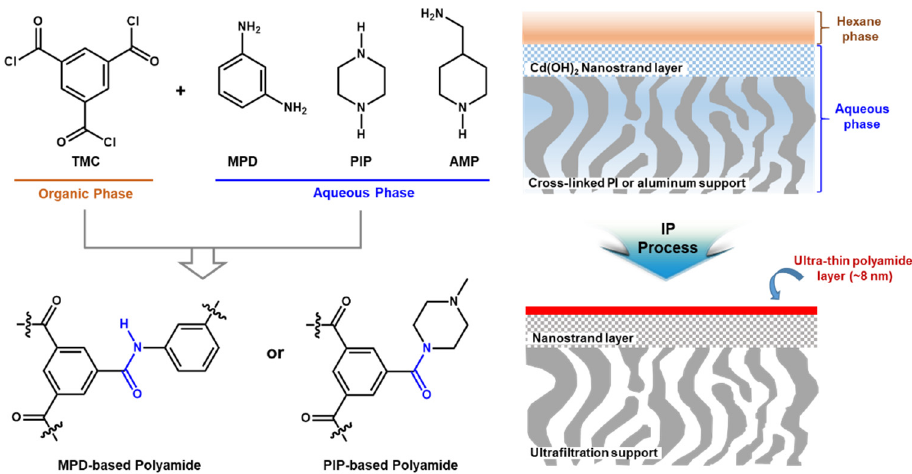
Figure 2. Ultra-thin m -phenylenediamine (MPD)-based and/or piperazine (PIP)-based polyamide selective layer with the ultrafast solvent transport.